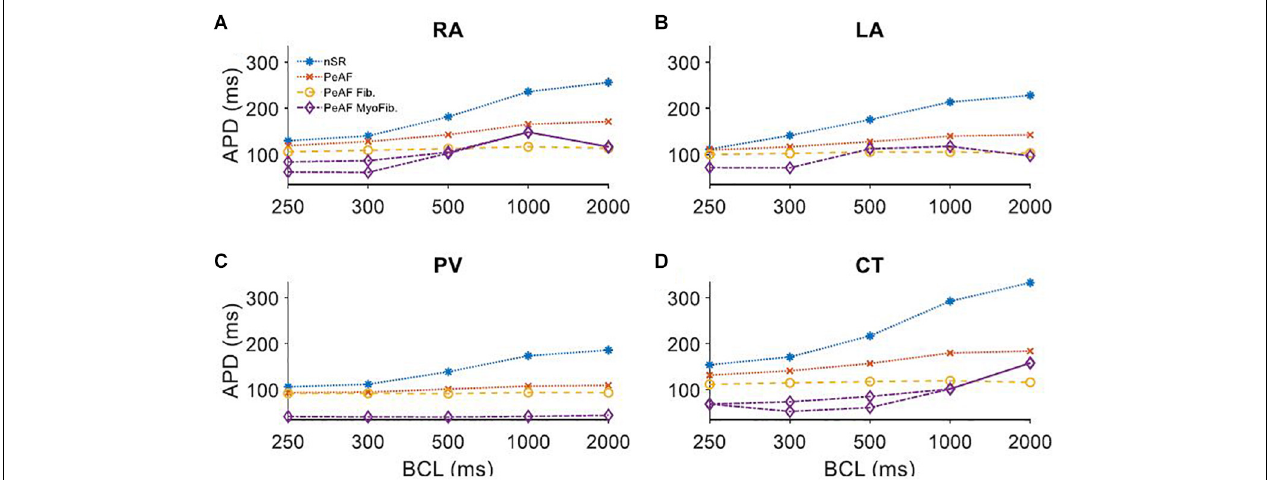
FIGURE 5 | Myocyte action potential duration (APD) of four different regions of the atria under persistent atrial fibrillation electrical remodeling (PeAF) coupled to three fibroblasts (Fib) or myofibroblasts (MyoFib) stimulated at different basic cycle lengths (BCLs). (A) Right atria (RA), (B) Left atria (LA), (C) Pulmonary vein (PV), and (D) Crista terminalis